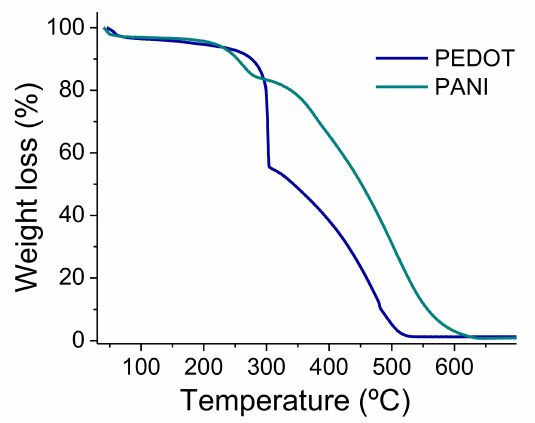
Figure 2. Weight loss as function of temperature of the synthesized